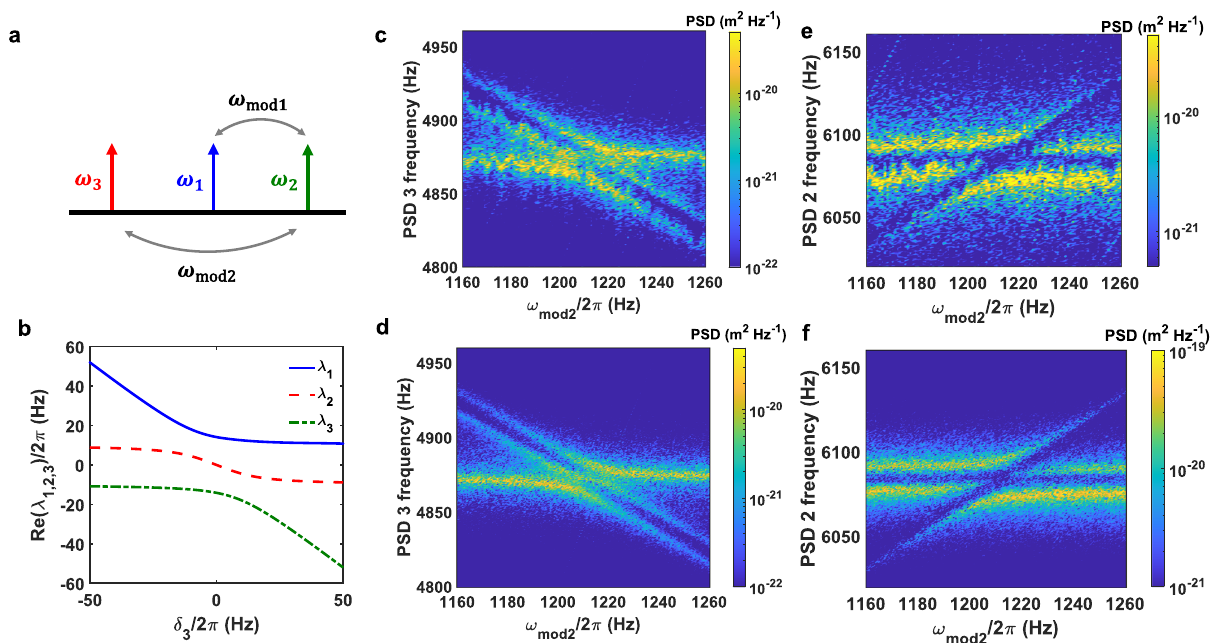
Fig. 2 | Coupling the vibrations of three cantilevers with the Casimir effect. between cantilever 1 and cantilever 2, and between cantilever 2 and cantilever 3, a Parametric modulation of the Casimir interaction is applied in our system. When respectively. c Measuredpowerspectrumdensity(PSD)ofcantilever3asafunction ω ω − ω ofthemodulationfrequency ω mod2 . e PSDofcantilever2asafunctionof ω mod2 .The mod1 = 2 1 ,cantilever1andcantilever2arecoupled.Similarly,cantilever2and cantilever 3 are coupled when ω mod2 = ω 2 − ω 3 . Here ω mod1,2 is the modulation fre- modulation amplitudes are δ d1 =10.4nm and δ d2 =14.1nm. The modulation fre- quency. b Three eigenvalues of the Hamiltonian in Eq. (2) as a function of δ 3 when quency ω mod1 is fi xed at 440Hz. d , f The simulated PSD for two cantilevers. The ∣ g ∣ = ∣ g ∣ =2 π ×20Hz. Here δ ω ω − ω δ ω ω − ω δ separations are d 10 =88nm and d 20 2 =0 and 12 23 2 = 1 + mod1 2 and 3 = 1 + mod1 mod2 − ω 3 are the detuning of the system. g 12 and g 23 are the coupling strengths